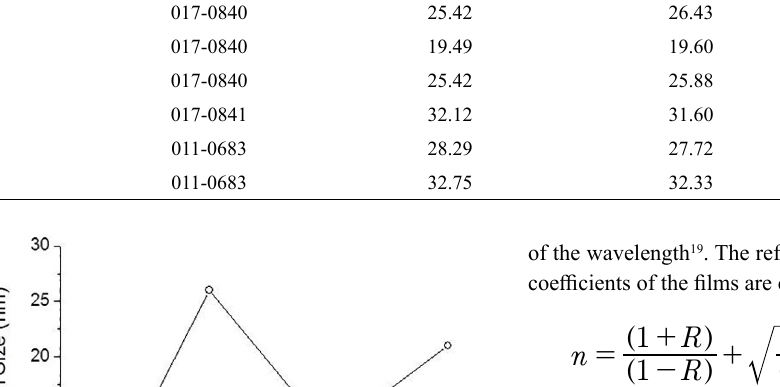
Figure 1. X-ray patterns of MnSeO4 films deposited at various pH levels: (a) pH 11, (b) pH 10, (c) pH 9 and (d) pH 8 Table 1. XRD datas of ASTM values versus films pH